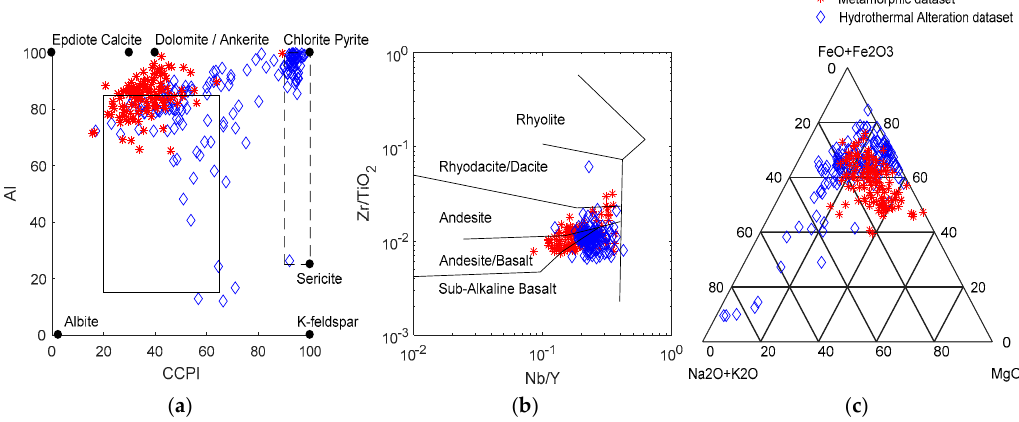
Figure 6. ( a ) Alteration boxplot plotting the CCPI against AI. Solid line box indicates the area where non-altered samples are expected to plot, dashed box indicates the area where samples altered by chlorite–sericite alteration are expected to plot. Dots represent the area’s where some minerals would plot. ( b ) Winchester plot of incompatible elements; ( c ) AFM-diagram of bulk rock element concentrations.